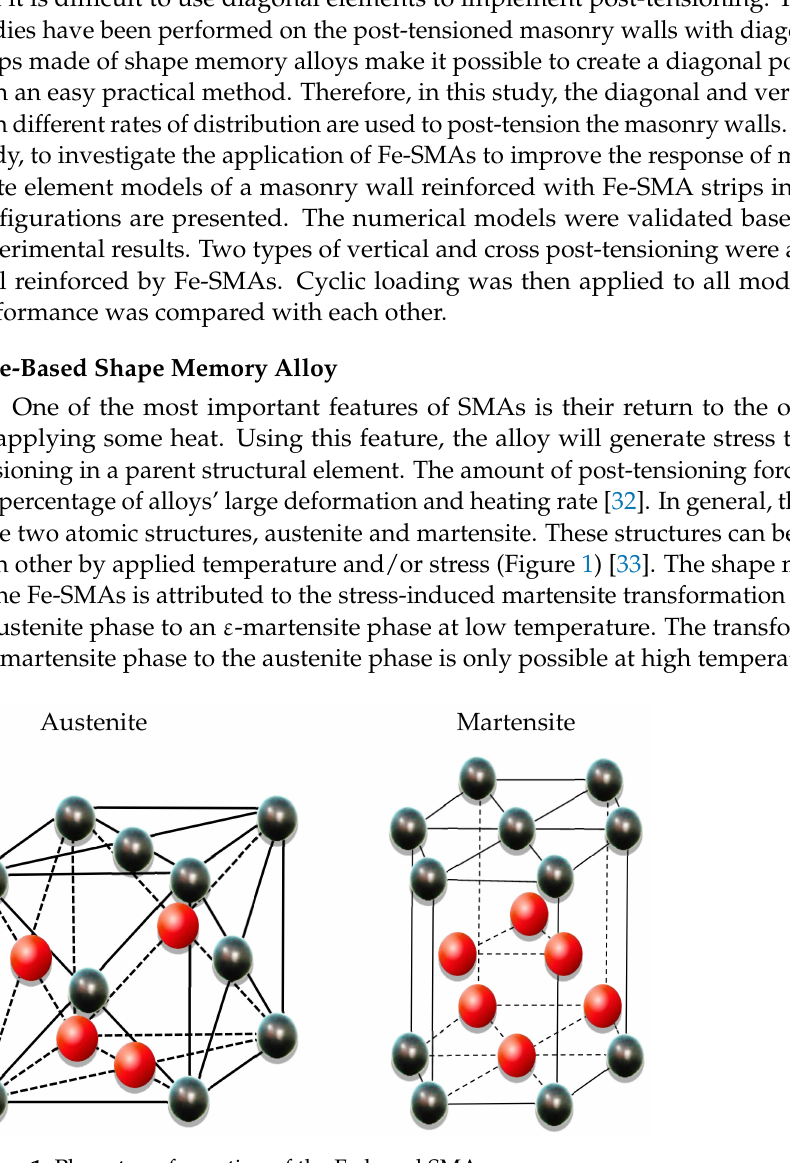
Figure 1. Phase transformation of the Fe-based